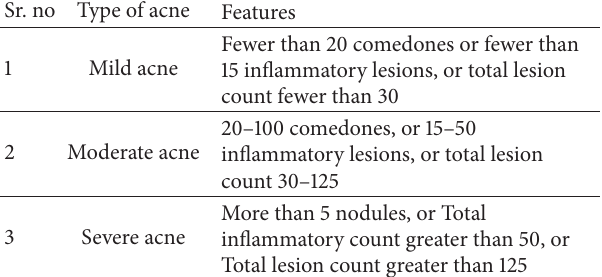
Table 2: Types of acne according to severity.